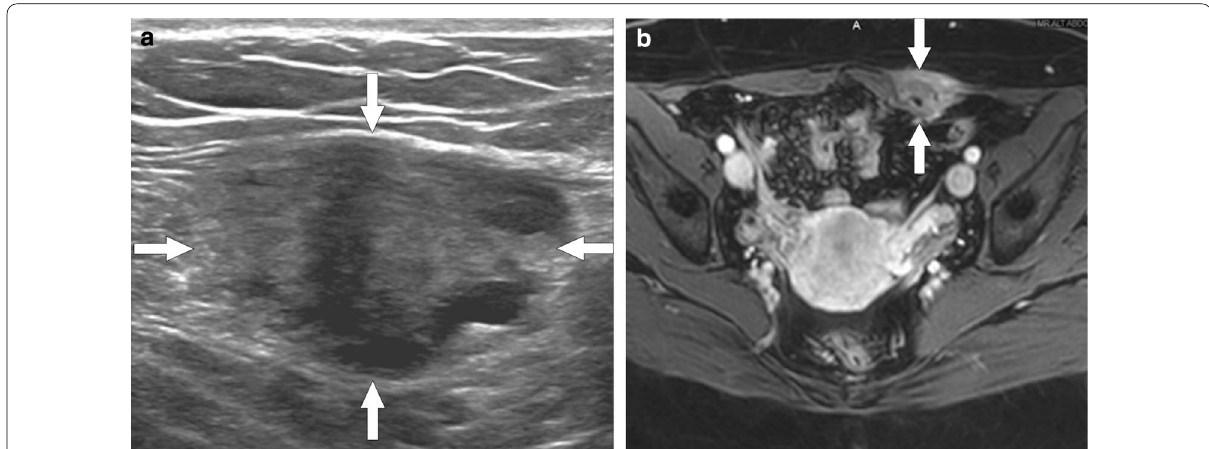
Fig. 27 Extrapelvic endometriosis mimicking metastatic implants. A 35-year-old woman with a history of gastric adenocarcinoma now presenting with palpable mass in the abdominal wall. a Gray scale US image shows solid mass with lobulated contours (arrows) within the left rectus abdomens muscle. b Axial postcontrast fat suppressed T1W MR image shows intense enhancement of the mass (arrows). The lesion was isointense to rectus abdominis muscle on T1W image, and hypointense on T2W images with internal hyperintense foci (not shown). The lesion was resected with a preliminary diagnosis of metastatic implant but histopathologic study confirmed endometrioma within rectus abdominis muscle